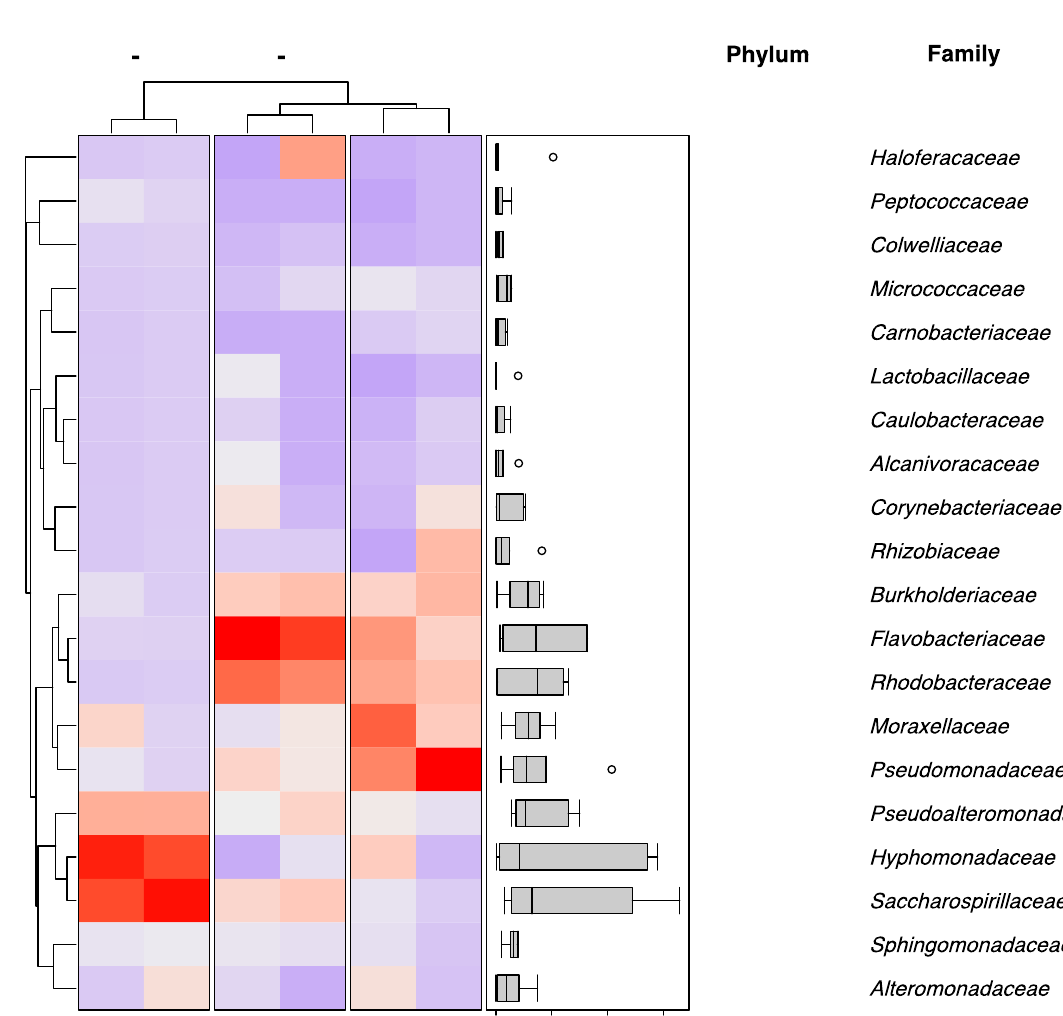
Figure 4. Heatmap visualizing the Z-score distribution from the relative abundance of the dominant families (>0.5% in average) initially (T0) and after 6 days of incubation under increasing pressure (T6-HP) and atmospheric pressure (T6 ATM) conditions. Z-score is the number of standard deviations separating a raw score from the mean. For each sample, we calculated how far from the mean (of a family relative abundance considering all samples) is the family abundance score of the sample. A positive Z-score indicates the raw score is higher than the mean (red color), and a negative Z-score reveals the raw score is below the mean (blue color). The higher the Z-score, the more overrepresented the family is for the sample compared to the mean. The dendrogram clusters were calculated with the UPGMA method (unweighted pair group method with arithmetic mean) according to the Bray–Curtis similarity index. The boxplots in the right panel show the distribution of family relative abundances (in %) for all samples.